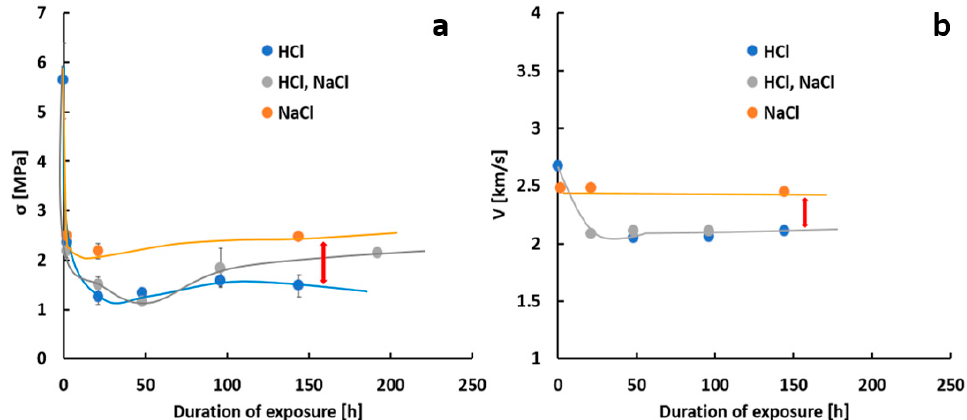
Figure 4. Shear strength ( a ) and P-wave velocity ( b ) vs. duration of sample exposure to 1 M NaCl (orange), 1 M HCl (blue), 1 M HCl and 2 additional hours in 1M NaCl (grey). Error bars indicate standard deviation from the mean value obtained for at least three samples. Wherever an error bar is not visible, the standard deviation is smaller than the size of markers.